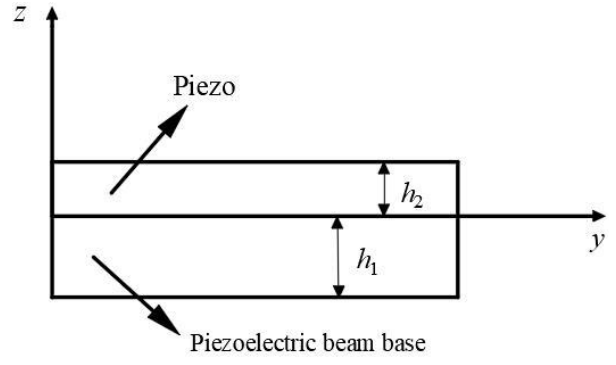
Figure 2. Schematic diagram of piezo beam cross-section.